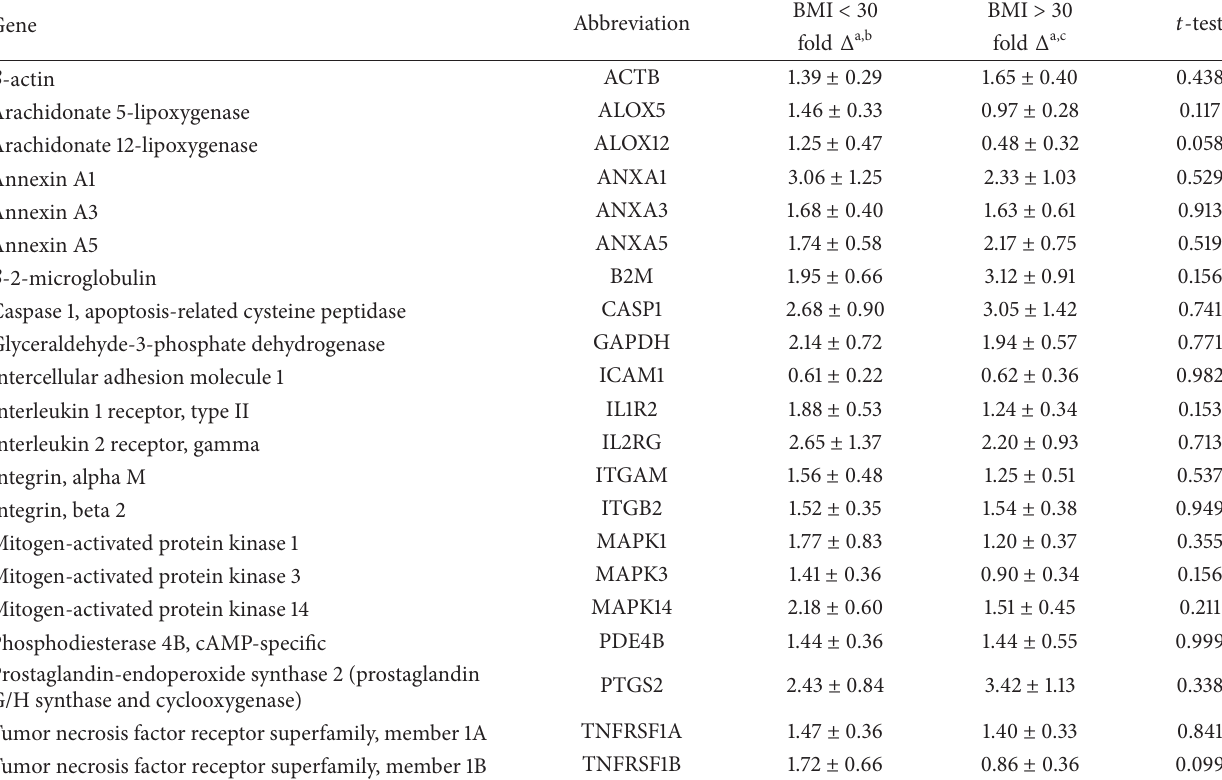
Table 5: Comparison of transcriptional changes in high and low BMI